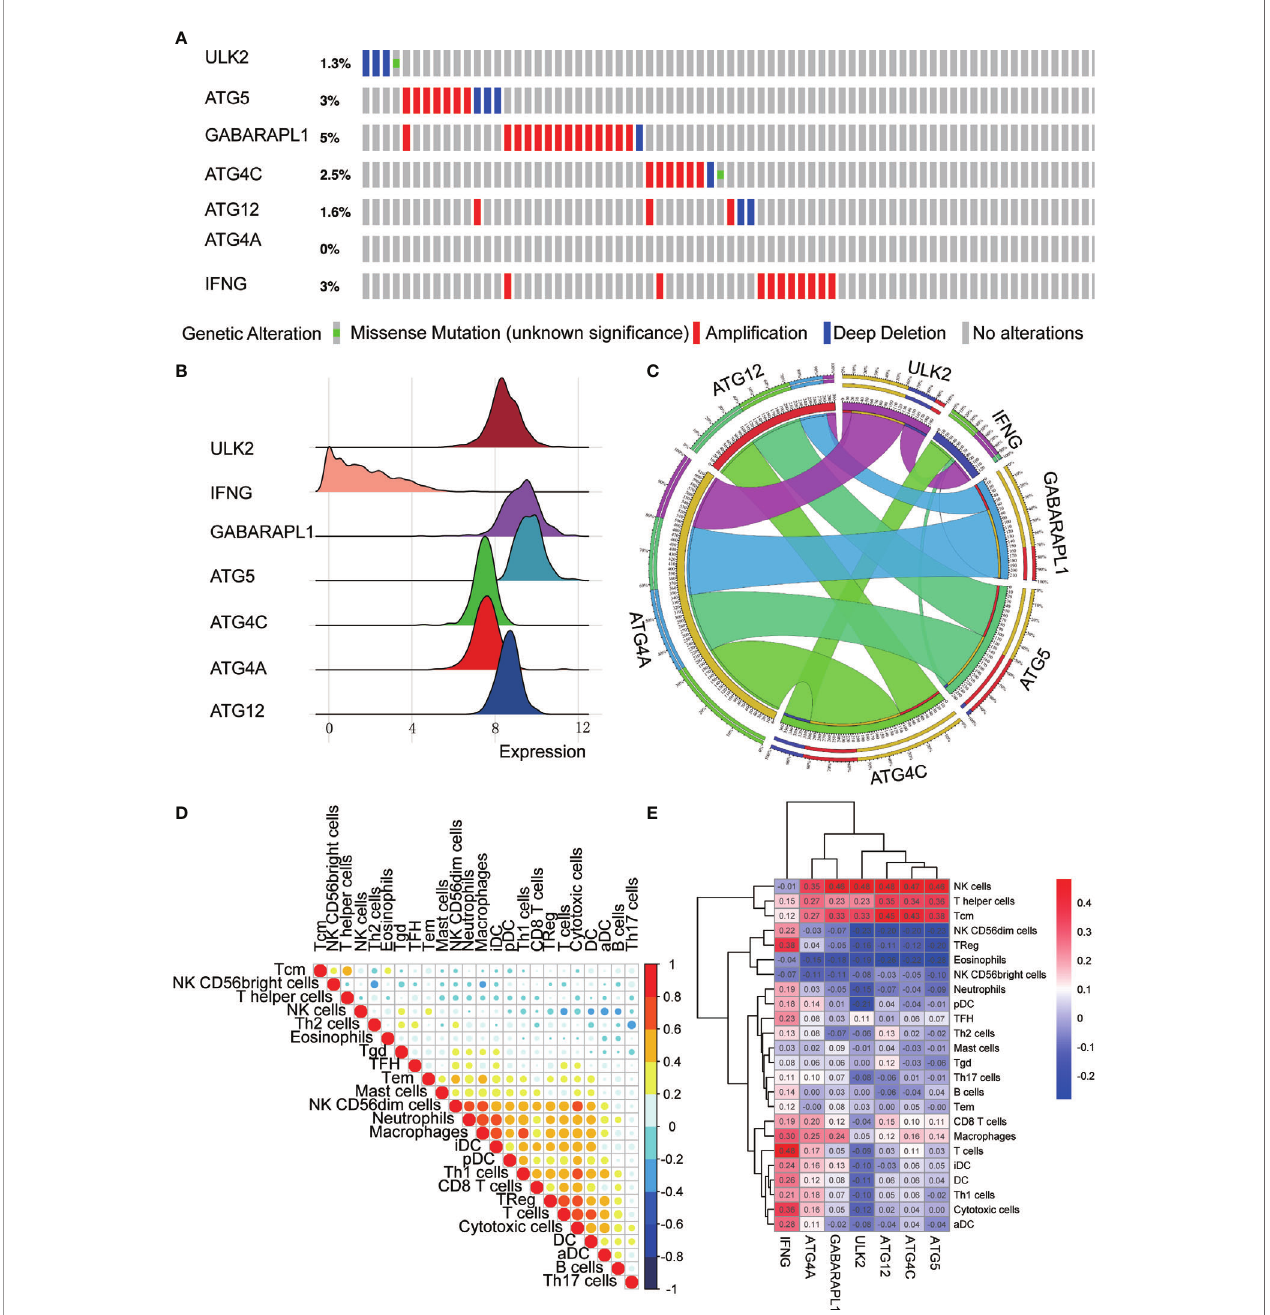
FIGURE 7 | ARG signature characteristics. (A) The waterfall plot of OC mutations established by 7 ARGs in the TCGA-OV cohort. (B) The height of the mountain represents the discrete situation between a set of data. The steeper the mountain is, the more concentrated the distribution of this group of data is, and there are few discrete values between the data; the gentler the mountain is, the more dispersed the group of data is. (C) Circos plot shows the correlations between the 7 ARGs. (D) Correlations between the 24 immune cells. (E) Heat map of the correlation between the 7 ARGs and the 24 immune